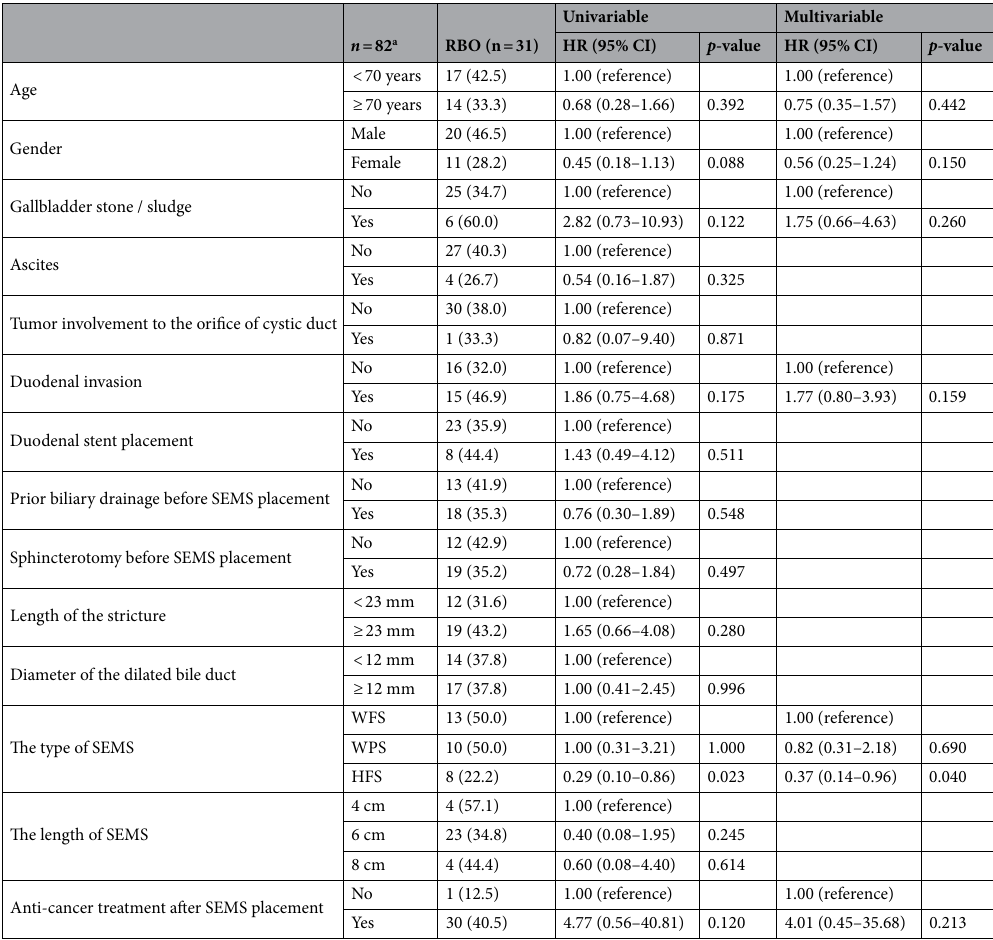
Table 3. The incidences of recurrent biliary obstruction according to various clinical factors. Data are presented as number (proportion). RBO Recurrent biliary obstruction, HR Hazard ratio, CI Confidence interval, SEMS Self-expandable metal stent, HFS HILZO fully covered stent, WPS WALLFLEX biliary RX partially covered stent, WFS WALLFLEX biliary RX fully covered stent. a Two patients in which SEMS was removed due to complications other than RBO were excluded.